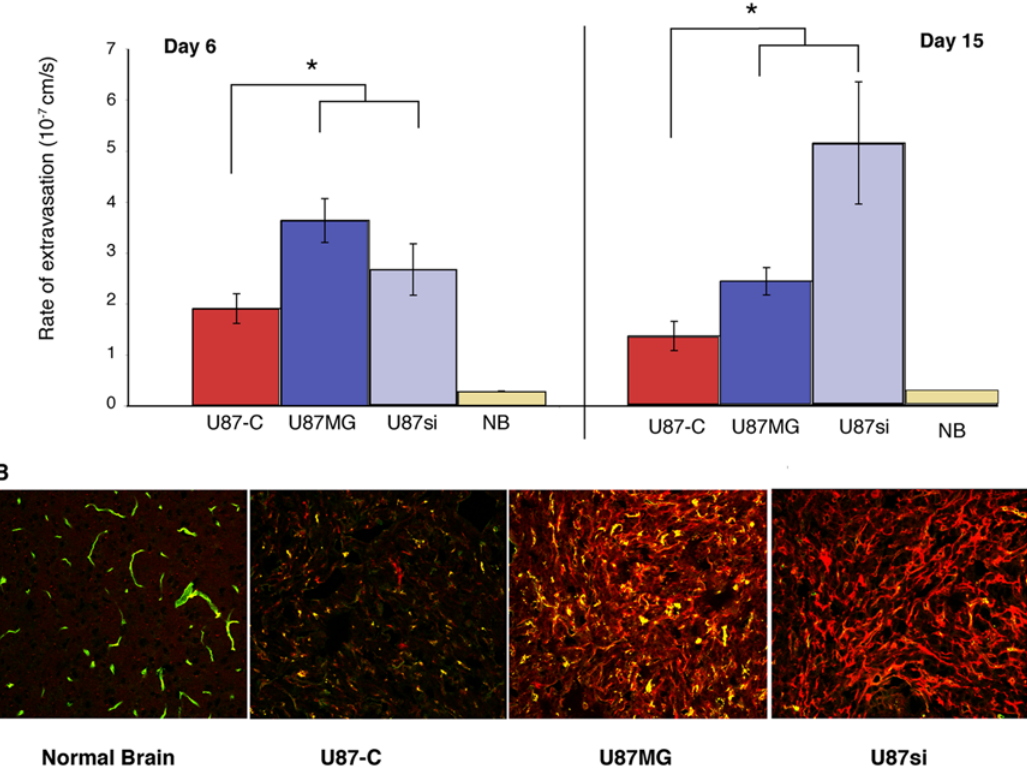
Figure 3. PDGF-C affects the transvascular flux of BSA. A : Effective vascular permeability was measured 6 days and 15 days after tumor implantation. The vessels in PDGF-C overexpressing tumors have lower permeability both 6 and 15 days following implantation. Normal brain (NB) vessels are relatively impermeable. B : Delivery of the BSA marker (red) is inhibited by PDGF-C overexpression (Green=CD31).